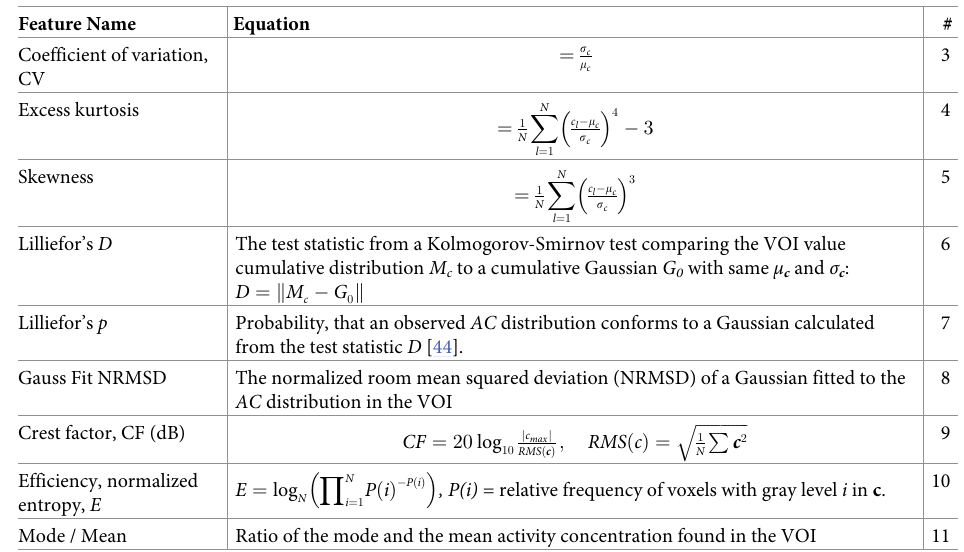
Table 2. First order statistical features used for texture